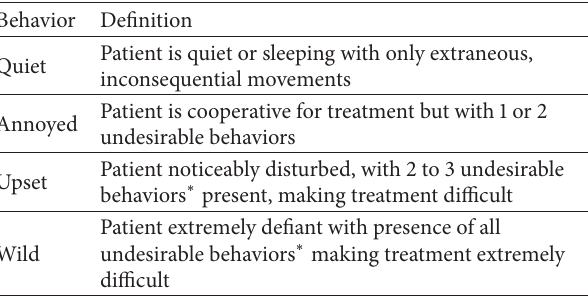
Table 3: Definition of North Carolina rating scale